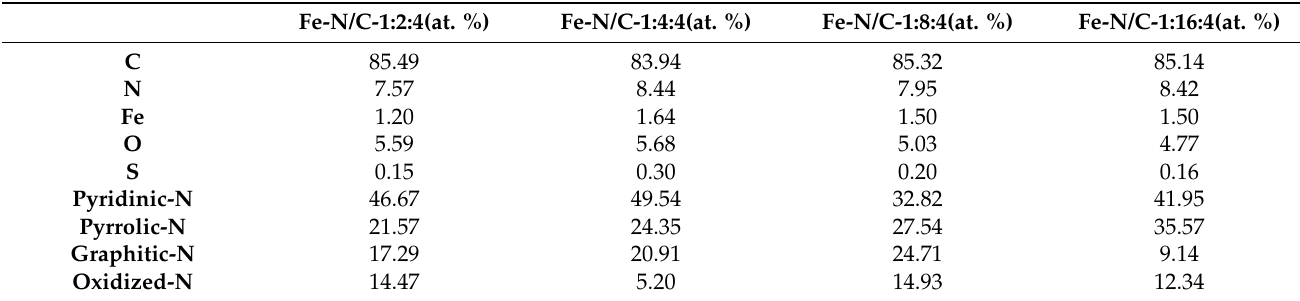
Table 1. The content of surface elements and different N species of Fe-N/C-1:2:4, Fe-N/C-1:4:4, Fe-N/C-1:8:4, and Fe-N/C-1:16:4 materials tested by XPS.